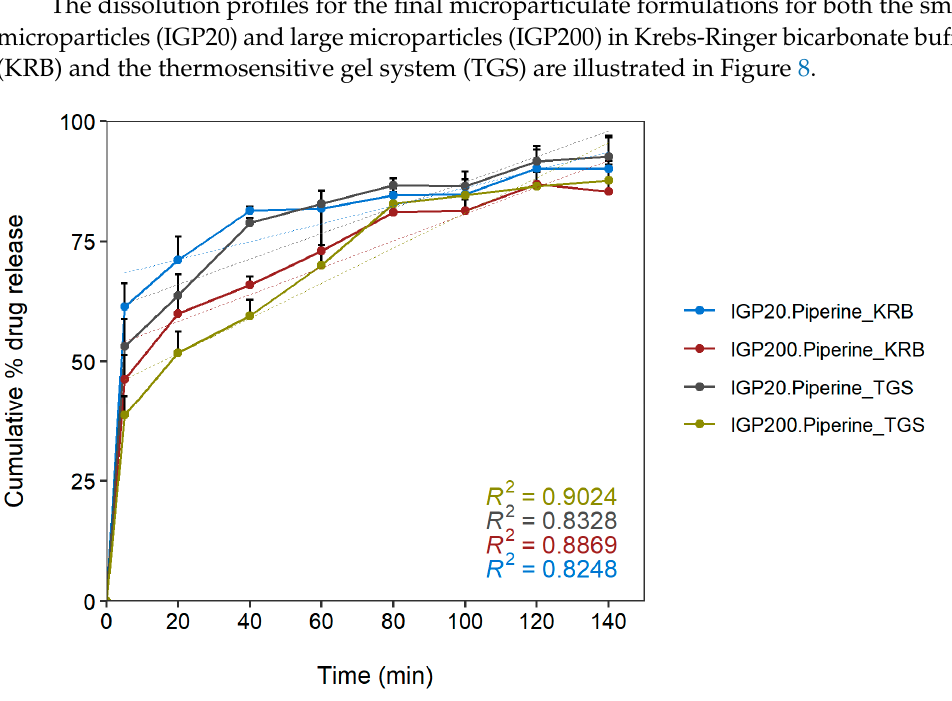
Figure 8. Dissolution profiles for the microparticle formulations (IGP20 and IGP200) and thermo- sensitive gel in Krebs-Ringer bicarbonate buffer. Data are expressed as the mean cumulative per- centage FD-4 release ± standard deviation; n = 6. IGP20: formulations aimed for microparticle size of ±20 µm, IGP200: formulations aimed for microparticle size of ±200 µm, KRB: Krebs-Ringer bicarbonate buffer, TGS: thermosensitive gel system.